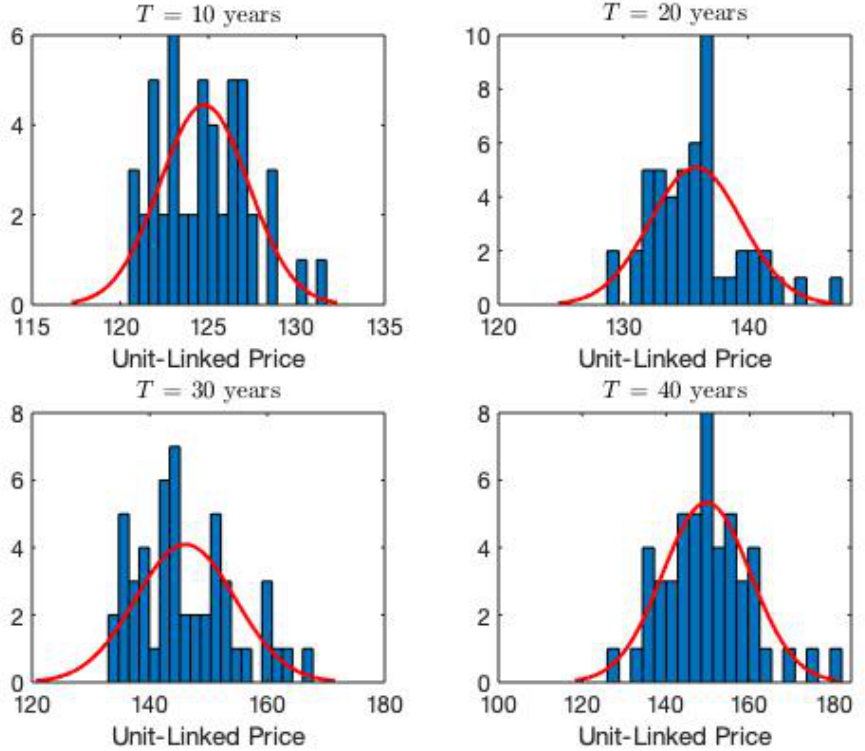
Figure 4. Unit-Linked Price histograms with constant survival rate equal to 1.